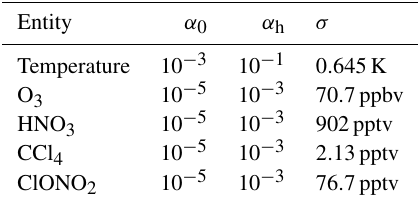
Table 1. Retrieval